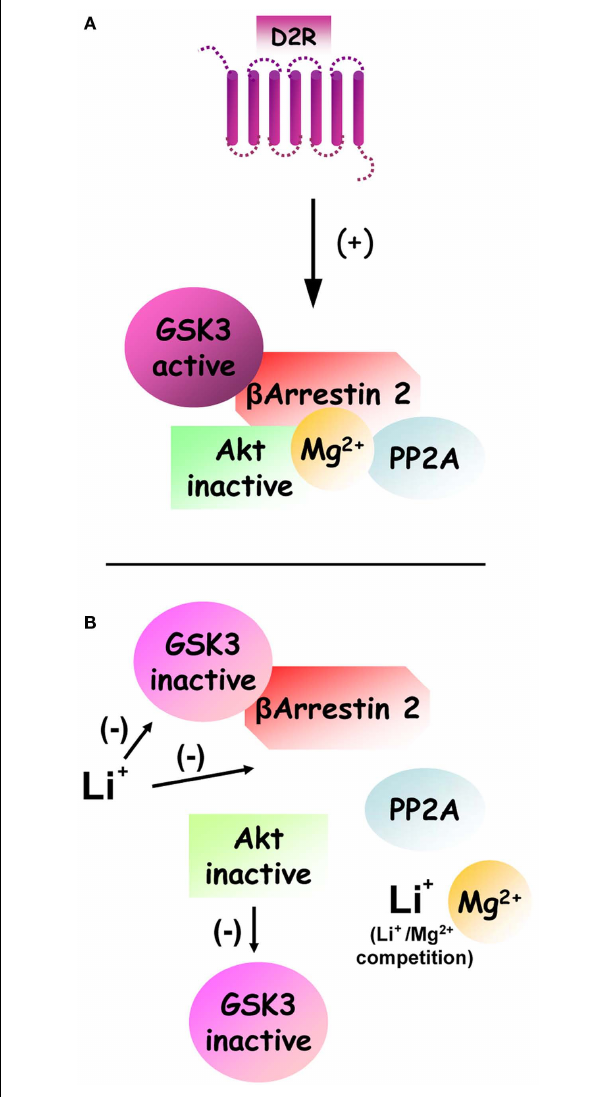
FIGURE 2 | Regulation of dopamine and D2R-dependent Akt: β Arr2:PP2A signaling complex by lithium and GSK3. (A) Under basal condition, the activation of D2R stimulates the formation of a signaling complex composed by beta-arrestin 2, PP2A, and Akt.The formation of this complex results in increased inactivation of Akt by PP2A. Furthermore enhanced activation of GSK3 that results from Akt inhibition would act as a positive feedback loop that further stabilizes the signaling complex. Finally, the formation of this complex also appears to be dependent on Mg 2 + to allow the interaction of Akt and beta-arrestin 2. (B) Following treatment with lithium, the formation of this signaling complex can be destabilized by two overlapping mechanisms. First a competition between Li + and Mg 2 + ions can disrupt the complex directly by preventing the interaction of Akt and beta-arrestin 2. Second direct inhibition of GSK3 by lithium prevents the stabilization of the complex by activated